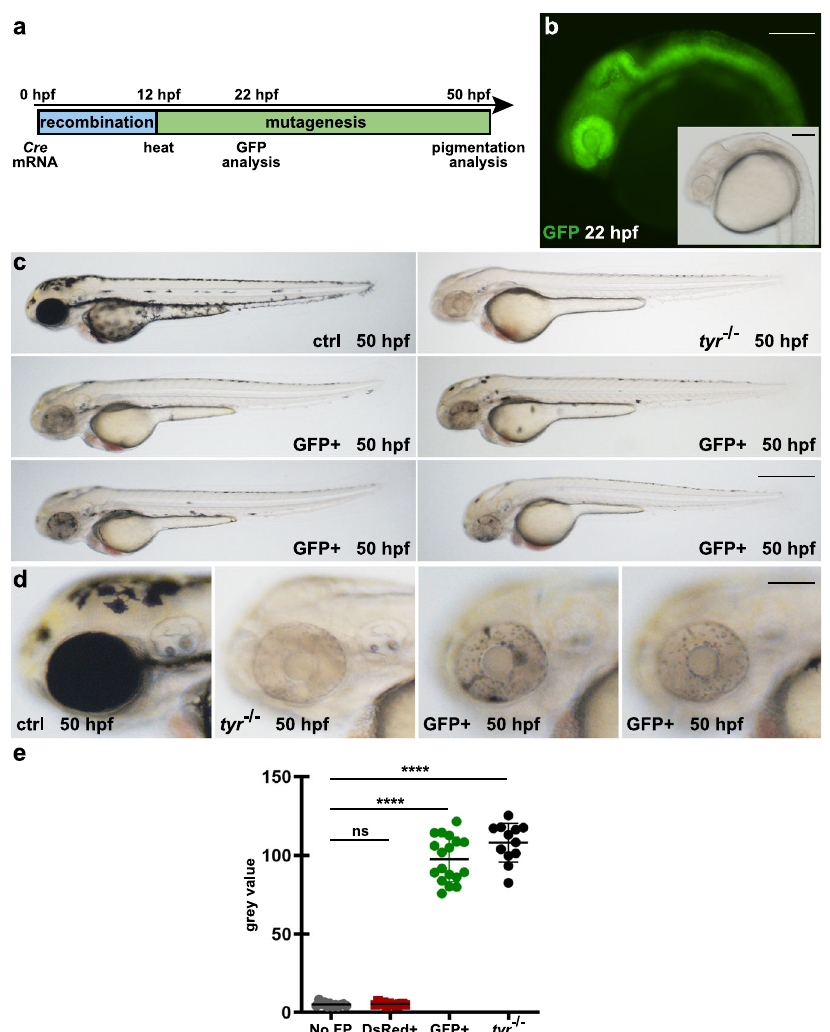
Fig. 2 Cre mRNA injections into 3C tyr result in ubiquitous GFP expression and widespread pigmentation defects. a Timeline. Cre mRNA injections at the 1-cell stage elicit ubiquitous recombination (blue box). At 12 hpf, a heat treatment triggers transient Cas9-GFP expression causing the subsequent permanent mutagenesis of the tyr target site (green box). Analysis of GFP expression and pigmentation was conducted at 22 and 50 hpf, respectively. b Expression of GFP is detected in a ubiquitous fashion at 22 hpf. In comparison to controls (ctrl), GFP-positive embryos (GFP + ) display a signi fi cant loss of black pigment along the body ( c ) and in the developing eye ( d ). Examples shown are representatives across fi ve experiments showing the same result. A total of >150 GFP-positive individuals and their respective non-GFP-positive siblings were analyzed. Scale bars: 150 µ m in b and d ; 500 µ m in c . e Graph showing quanti fi cation of RPE pigmentation determined using the mean of the histogram from images of control embryos expressing no fl uorescent protein (Non-FP), DsRed-positive (DsRed + ), and GFP-positive (GFP + ) siblings as well as tyrosinase mutants ( tyr − / − ) at 50 hpf. n (Non-FP, DsRed + , tyr − / − ) = 12; n (GFP + ) = 18. Data were analyzed using one-way ANOVA, followed by Tukey ’ s post hoc test. Values are presented as mean ± SEM; **** p ≤ 0.0001, ns (non-signi fi cant)